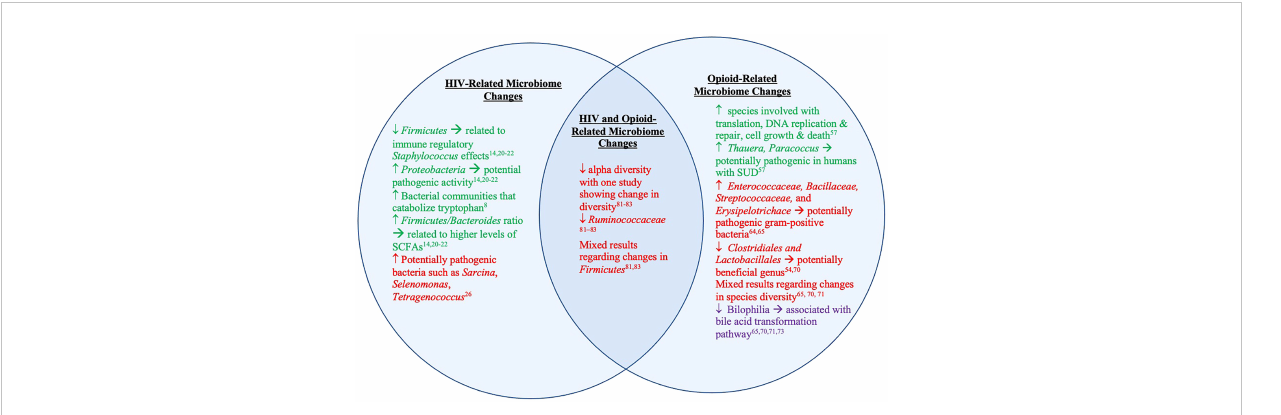
FIGURE 3 Microbiome and metabolite changes in clinical and preclinical studies of HIV and opioid use. The left represents microbiome and metabolite changes in PLWH and animal models of HIV/SIV. The right represents microbiome and metabolite changes in those with OUD and animal models of opioid use/OUD. The middle represents the overlapping microbiome detailed in existing animal models of both HIV/SIV and opioid use. The text in green represents information from studies done in humans. The red text represents information from studies done in animal models of HIV/SIV and opioid use. The text in purple represents information from both studies done in humans and